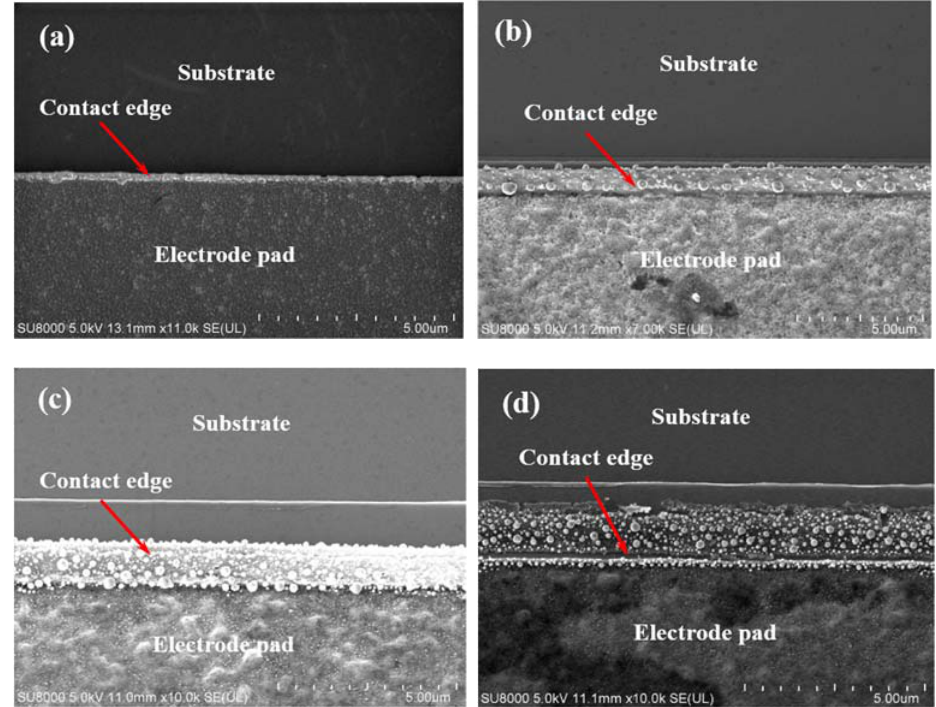
Figure 10. The SEM images of TLM electrode morphology at the annealing temperature of ( a ) 700 °C, ( b ) 750 °C, ( c ) 800 °C, and ( d ) 850 °C. ( b ) 750 ◦ C, ( c ) 800 ◦ C, and ( d ) 850 ◦